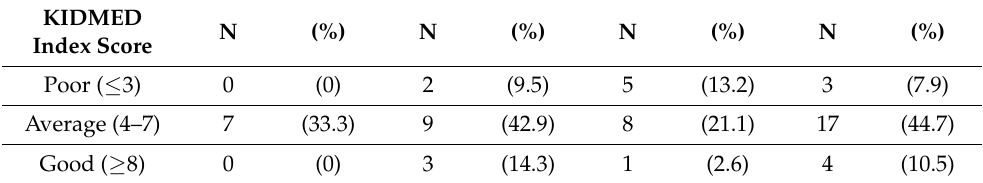
Table 2. Mediterranean diet quality total score for total